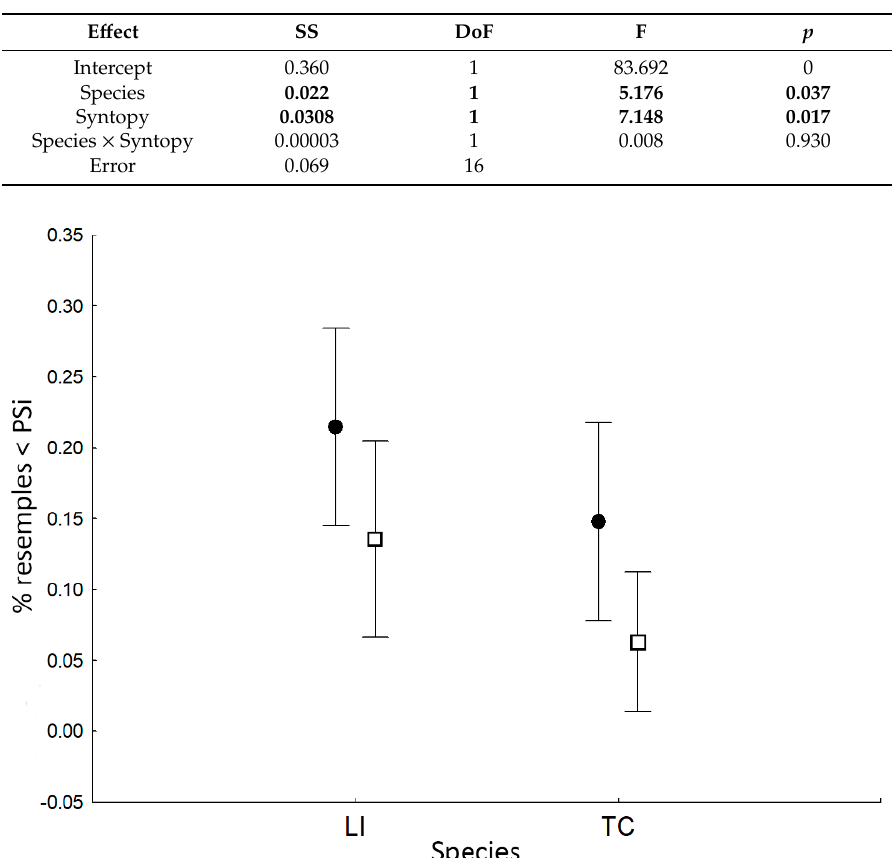
Table 3. Effect of species, syntopy, and interaction terms of fixed factors on the percentage of resampling PSi < observed Psi of L. italicus and T. carnifex populations (see Material and Methods). Lissotriton vulgaris was excluded from the analysis since it was always found in syntopic condition with other species. Significant effects are highlighted in bold.